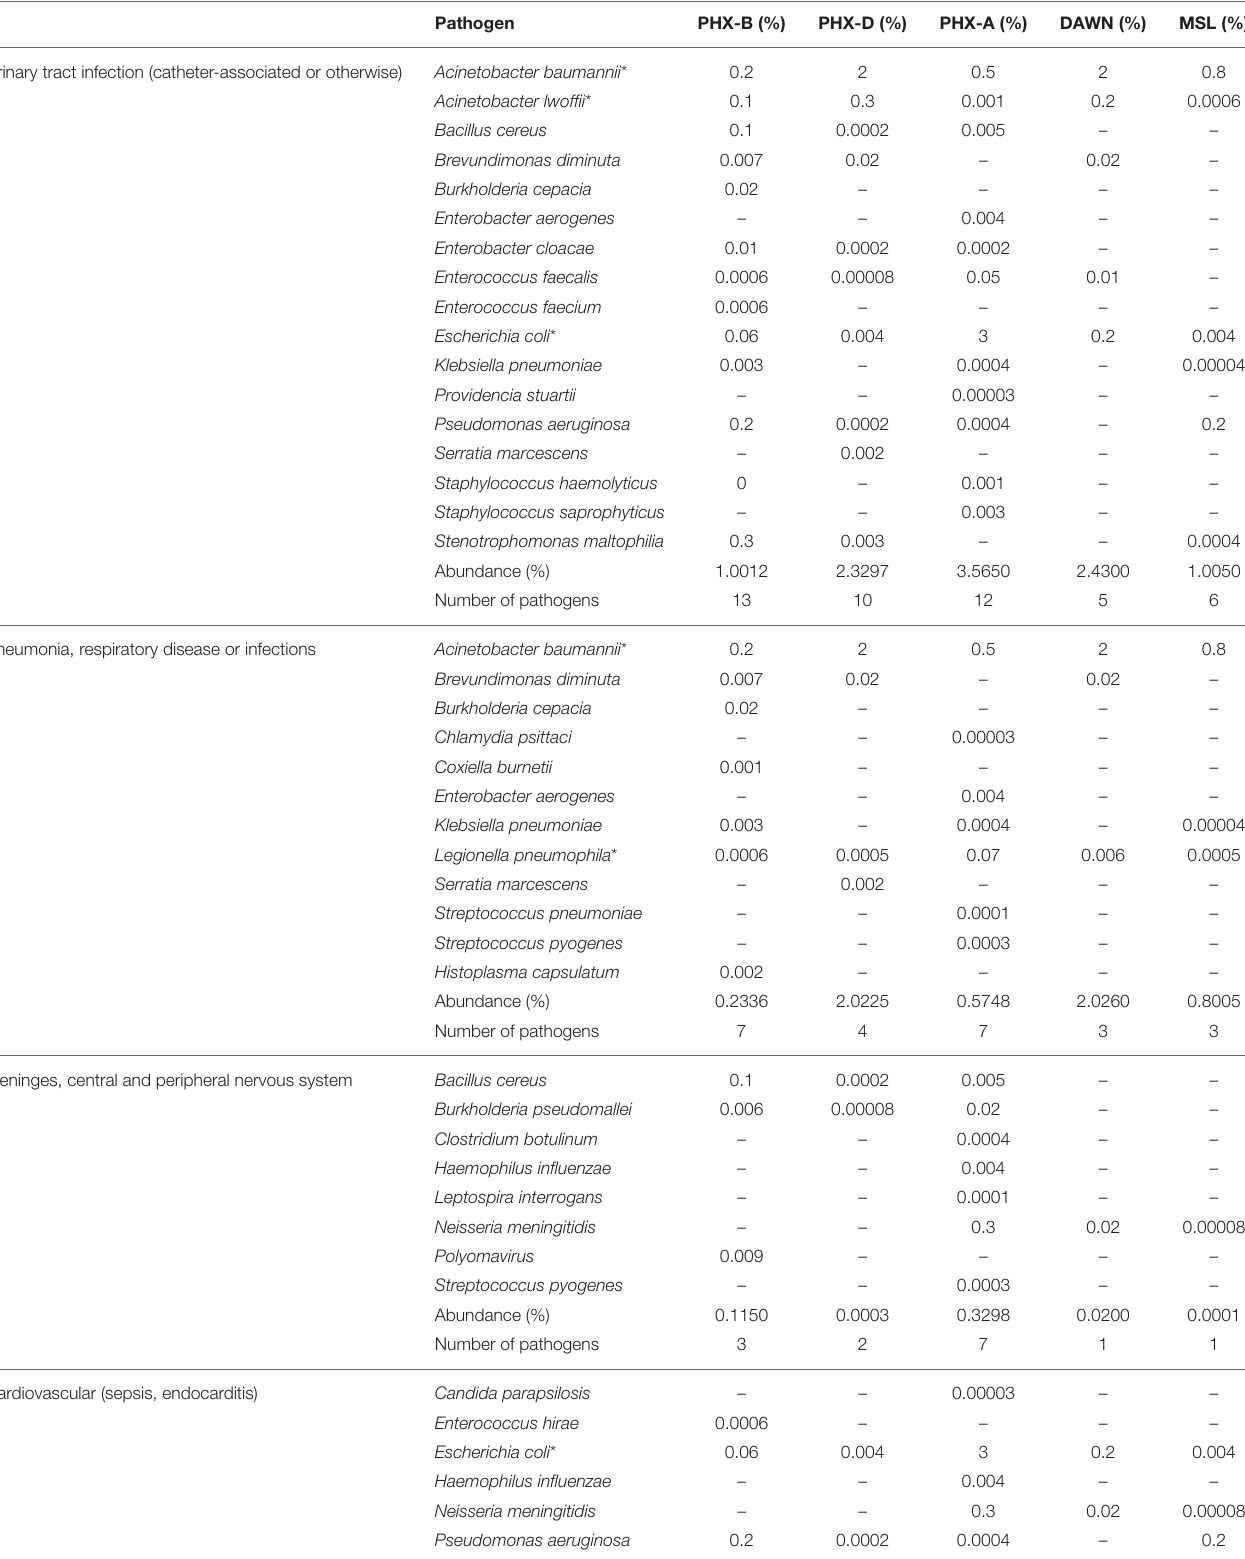
TABLE 2 | Pathogen diversity is lowest during assembly: pathogens found in the different cleanroom